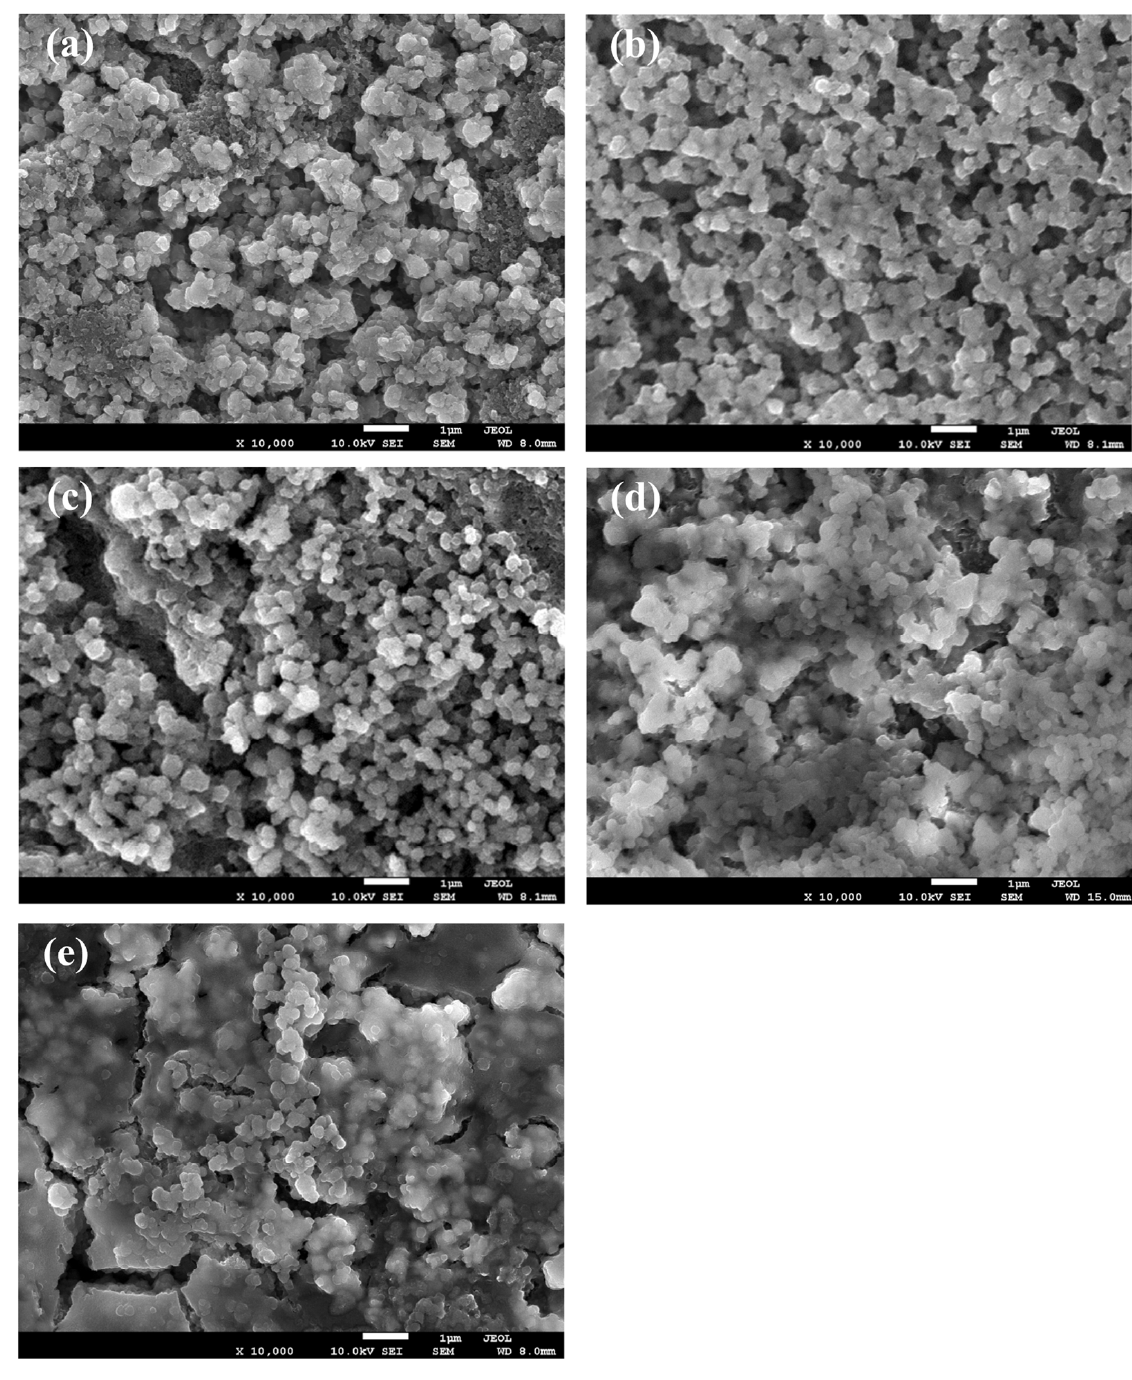
Figure 5. SEM images of ( a ) free additive, ( b ) 0.5 wt.% BS, ( c ) 1.0 wt.% BS, ( d ) 2.0 wt.% BS, and ( e ) 4.0 wt.% BS at the 0.5 C-rate for 50 cycles.